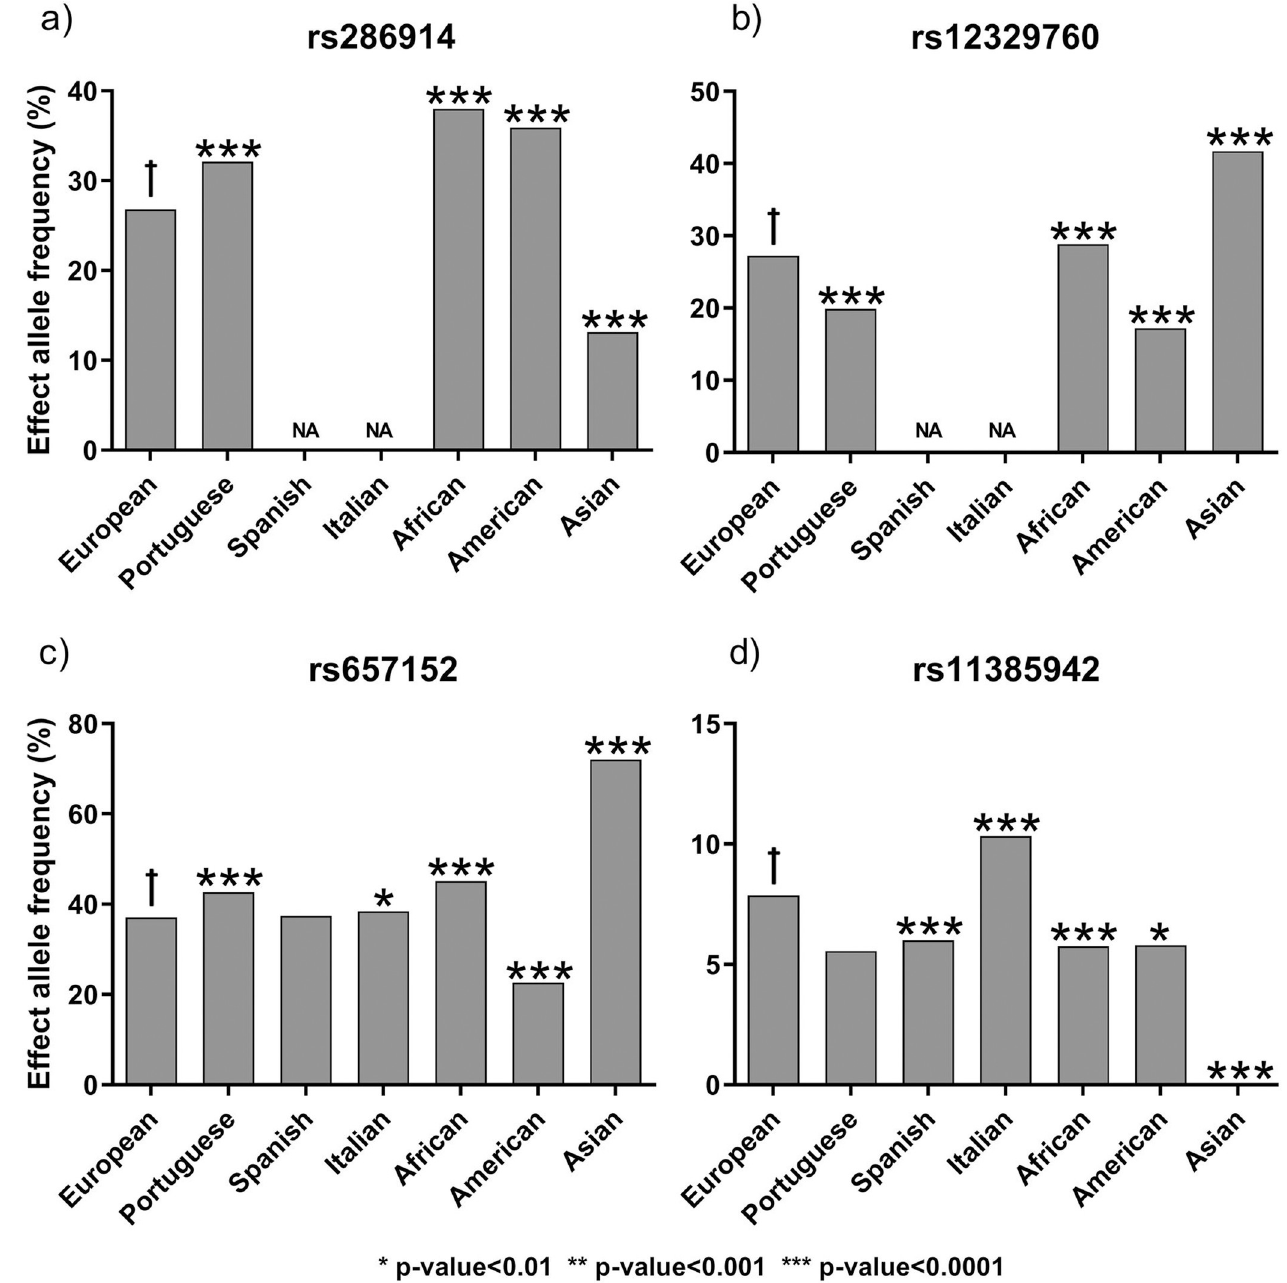
Fig 4. Effect allele proportions for COVID-19 susceptibility (a and b) and severe response to COVID-19 infection (c and d) SNPs in different world populations. Bars represent the proportion of each allele in the respective population. Allele frequencies for rs286914, rs12329760 and rs11385942 were obtained from gnomAD-Genome project, while rs657152 allele frequencies were obtained from the ALFA project. � : p-value < 0.01; �� : p-value < 0.001; ��� : p- value < 0.0001; - population used as reference for statistical analyses. NA—No data available. The remaining populations displayed a higher resemblance in their risk distribution. As for the severe COVID-19 with respiratory failure, the Italian population had the highest estimated number of people, 1576 per million, being double-homozygous for the risk SNPs (total of 4 risk alleles) (Fig 6B). Alternatively, the American population had an enrichment of people